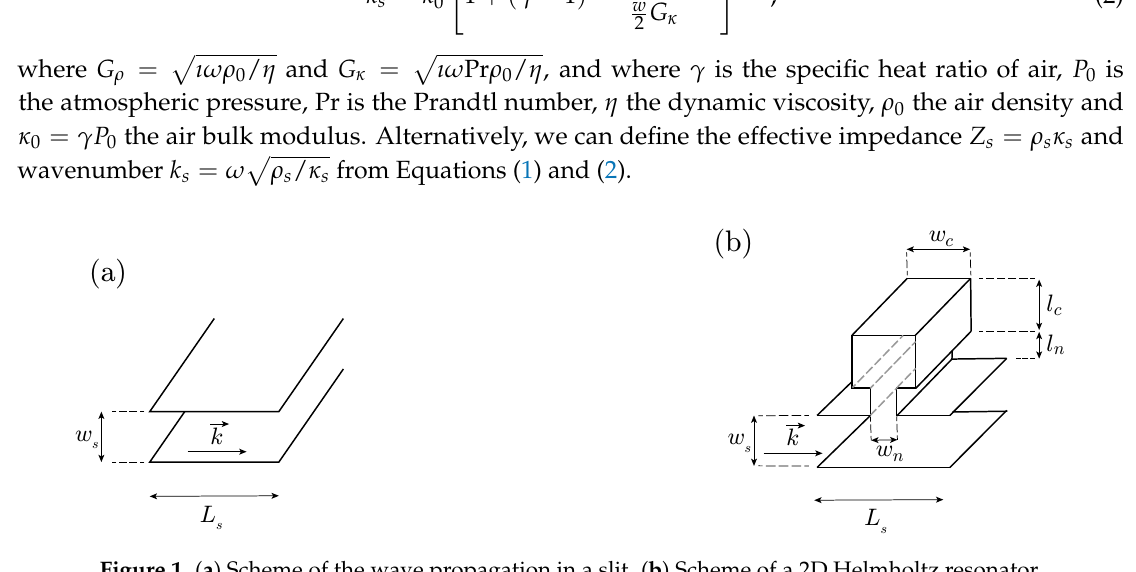
Figure 1. ( a ) Scheme of the wave propagation in a slit. ( b ) Scheme of a 2D Helmholtz